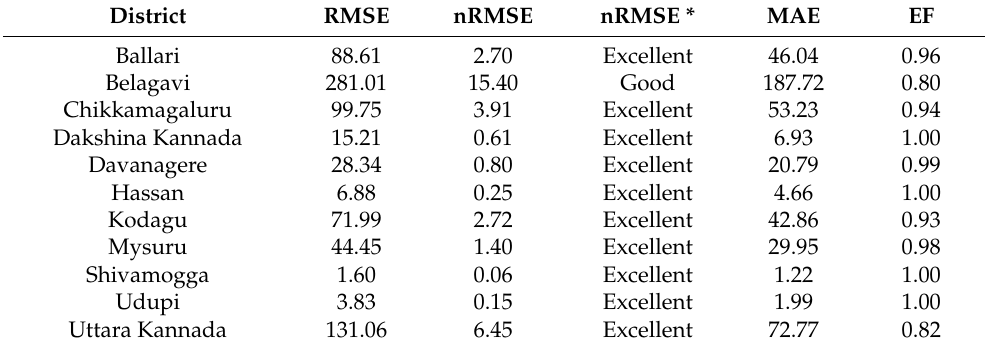
Table 8. Statistical evaluation of validated kharif rice yield using an artificial neural network (ANN). District RMSE nRMSE nRMSE * MAE EF